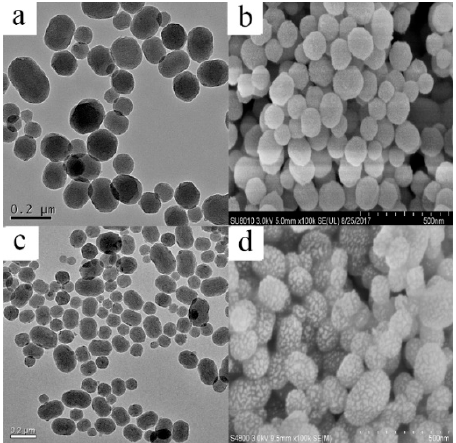
Figure 2. Scanning electron microscope (SEM) images: ( a ) mesoporous silica nanoparticles (MSNs), scale bar = 0.2 μ m ( c ) Fenoxanil-loaded MSNs (Fen@MSNs), scale bar = 500 nm; transmission electron microscope (TEM) images: ( b ) MSNs, scale bar = 0.2 μ m; ( d ) Fen@MSNs, scale bar = 500 nm.